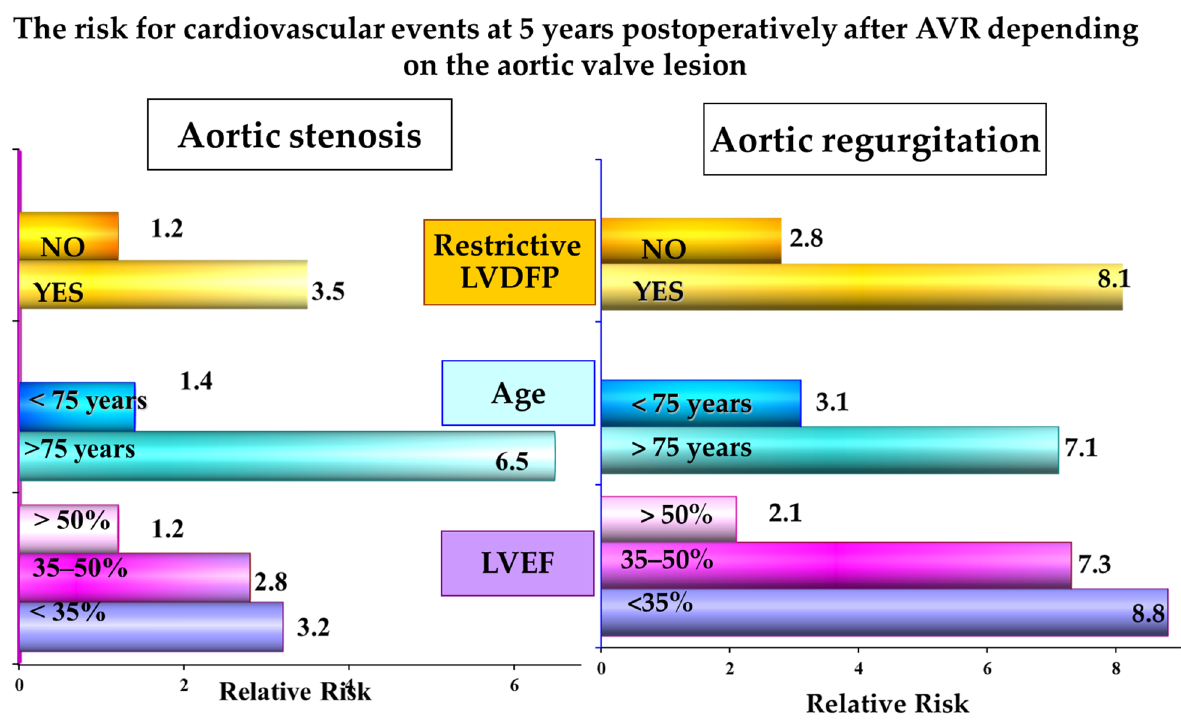
Figure 3. Risk for cardiovascular events at 5 years postoperatively after AVR depending on the type of aortic valve lesion.